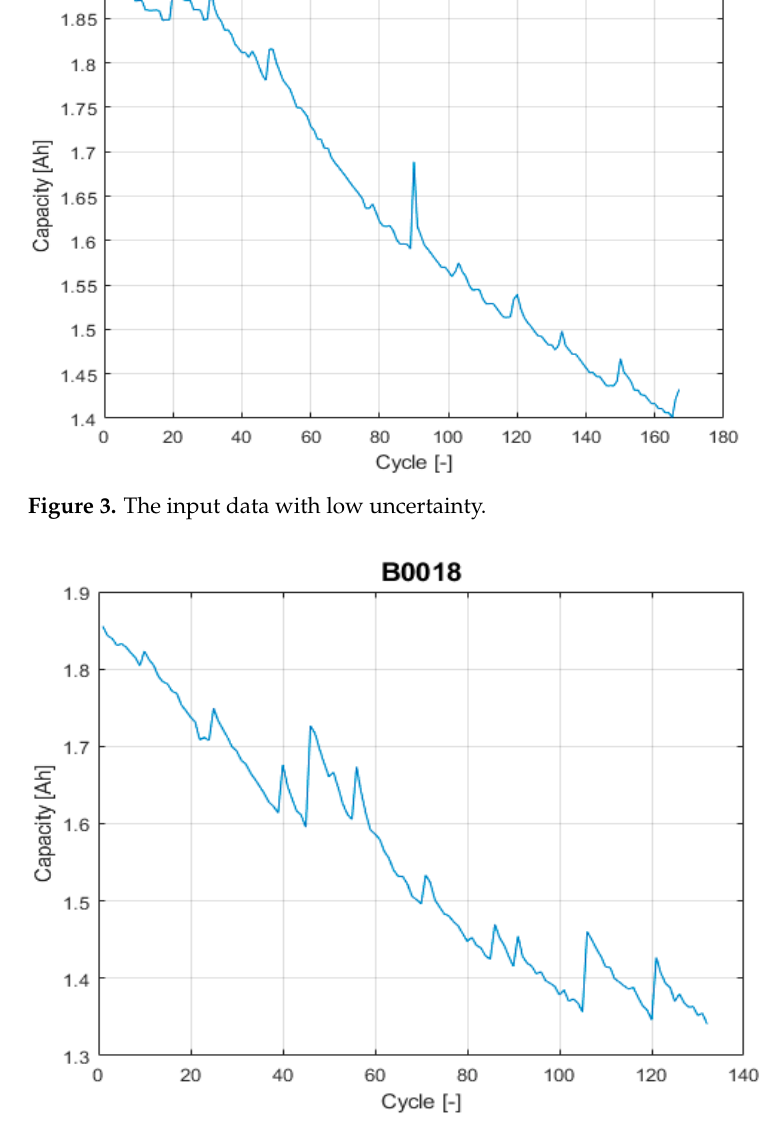
Figure 4. The input data with high uncertainty.